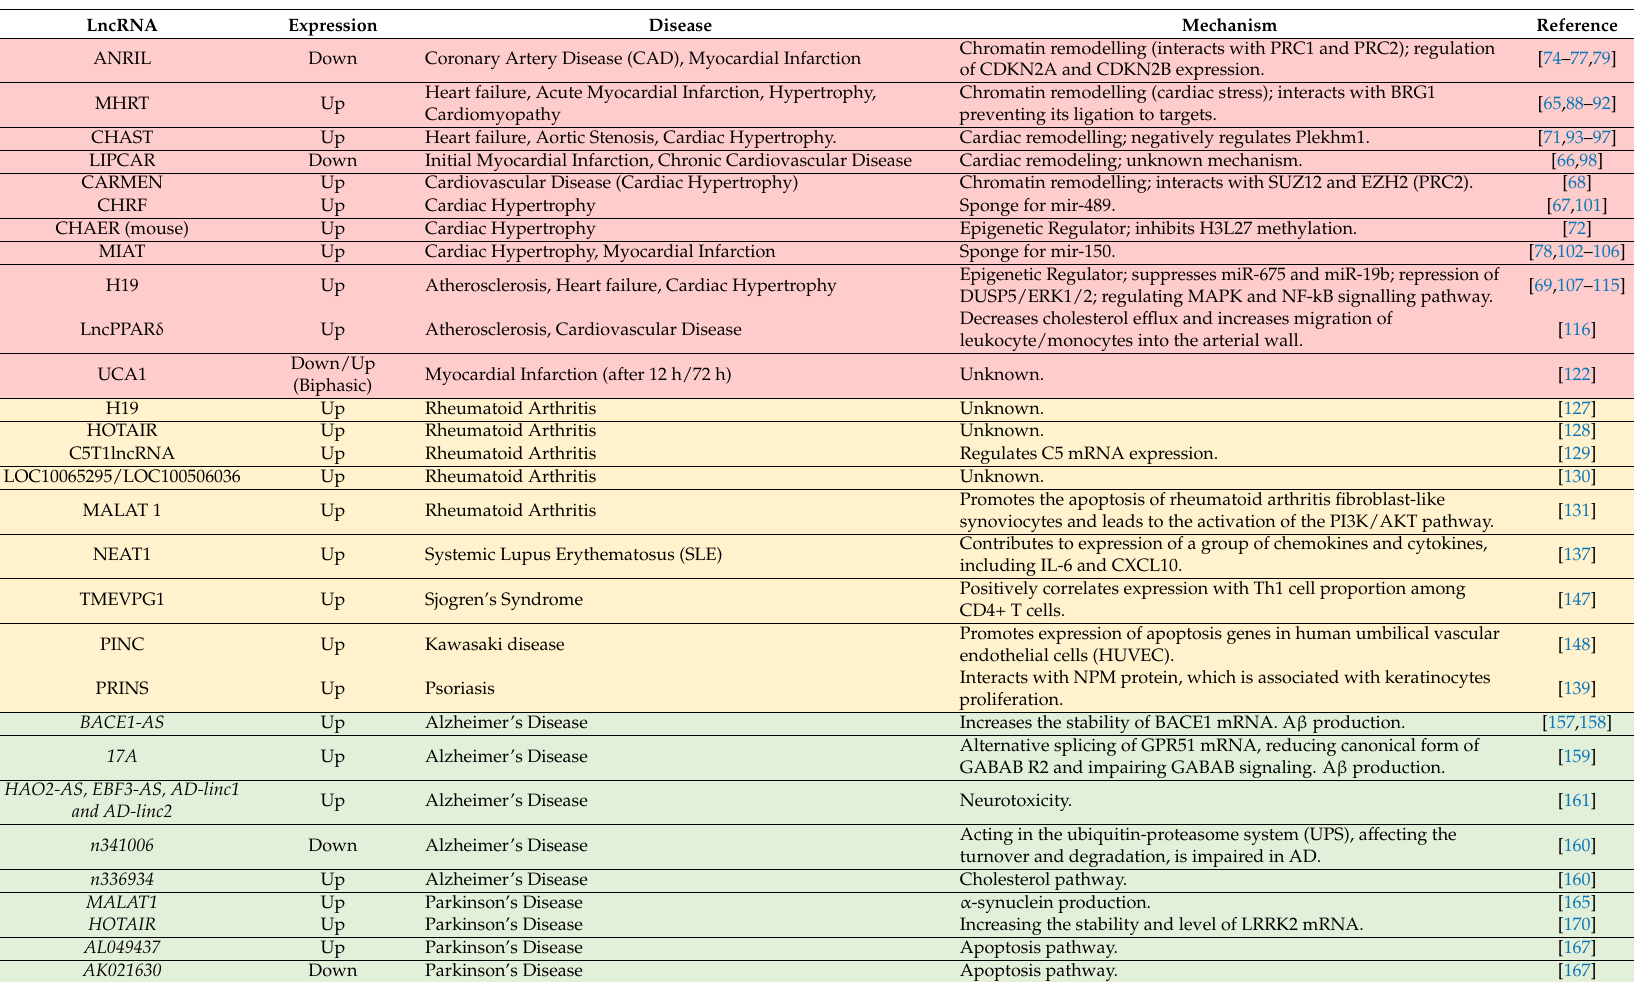
Table 1. List of the most relevant lncRNAs and the associated